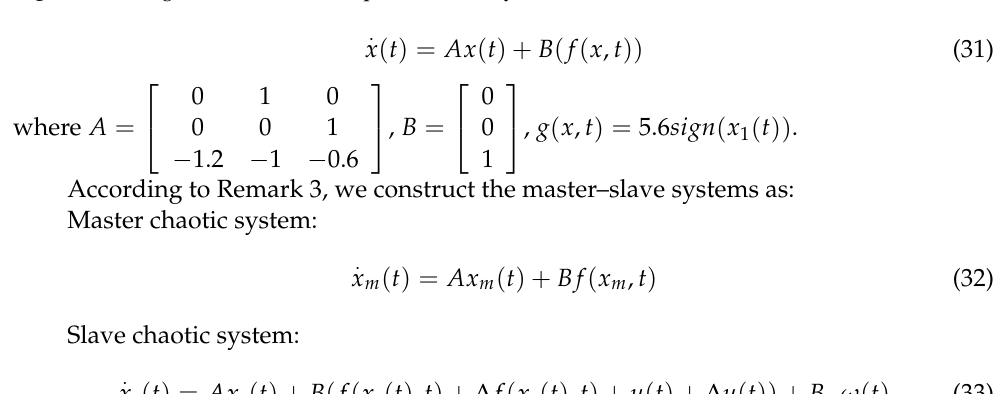
Figure 1. Strange attractors of the Sportt chaotic system.